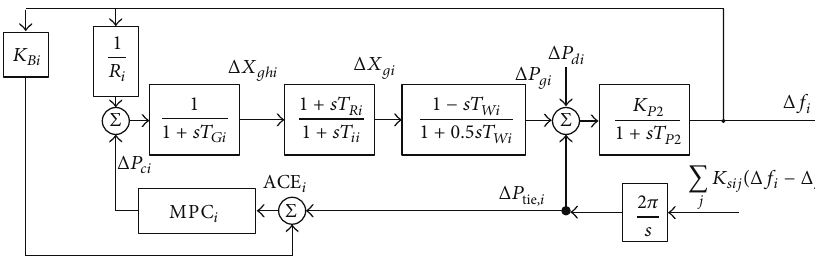
Figure 3: Block diagram of a hydro power plant ( 𝑖 = 2, 3 ).